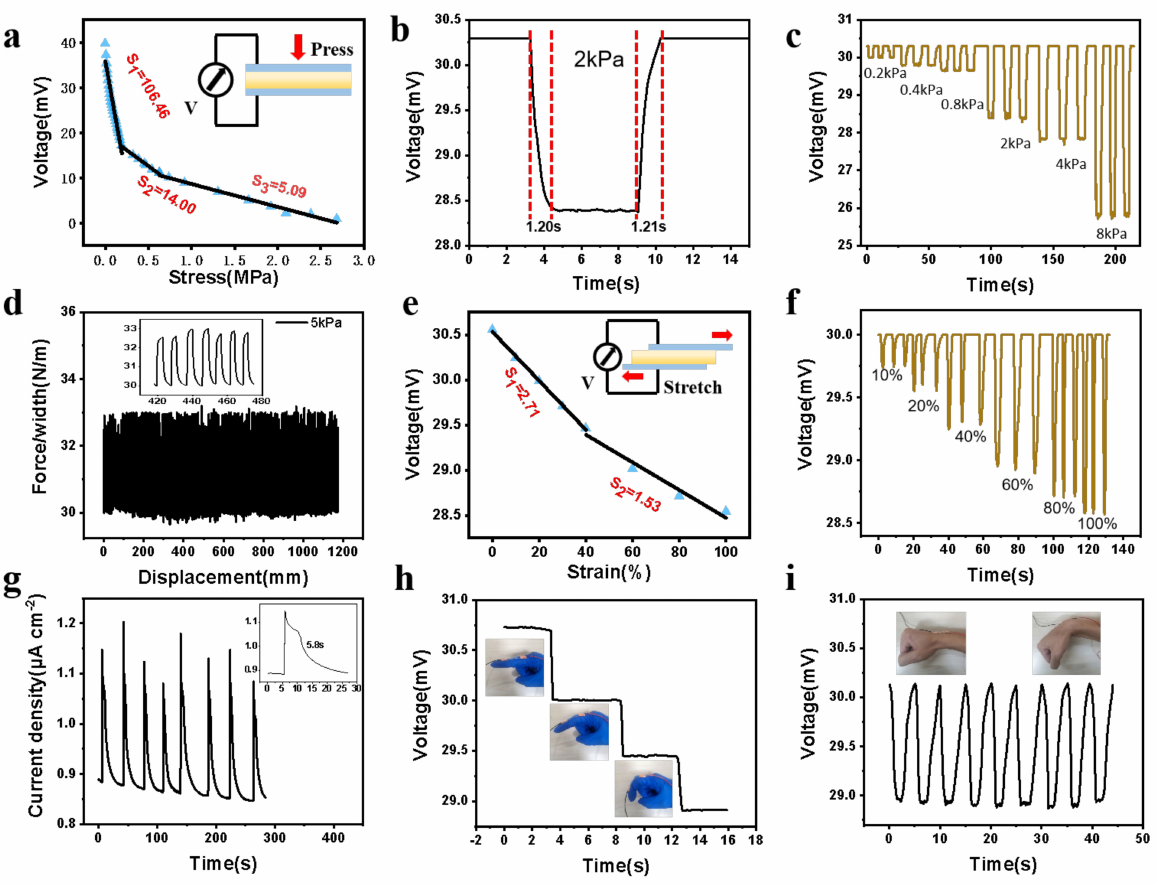
Figure 5. Pressure- and strain-sensing performance of the self-powered hydrogel sensors. ( a ) Output voltage of sensors as a function of pressure. ( b ) Output voltage under a 2 kPa static pressure. ( c ) Output voltage at different pressures. ( d ) Repeated loading/unloading of 5 kPa pressure for 200 cycles. ( e ) Gradually increased tensile strain and ( f ) different tensile strain. ( g ) Current signals of sensor in response to the 5 kPa pressure. Recorded voltage signals of the sensors in response to ( h ) finger joint motions and ( i ) wrist joint